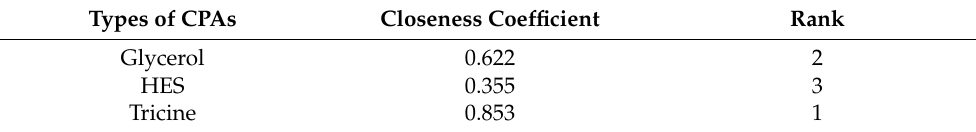
Table 2. The result of